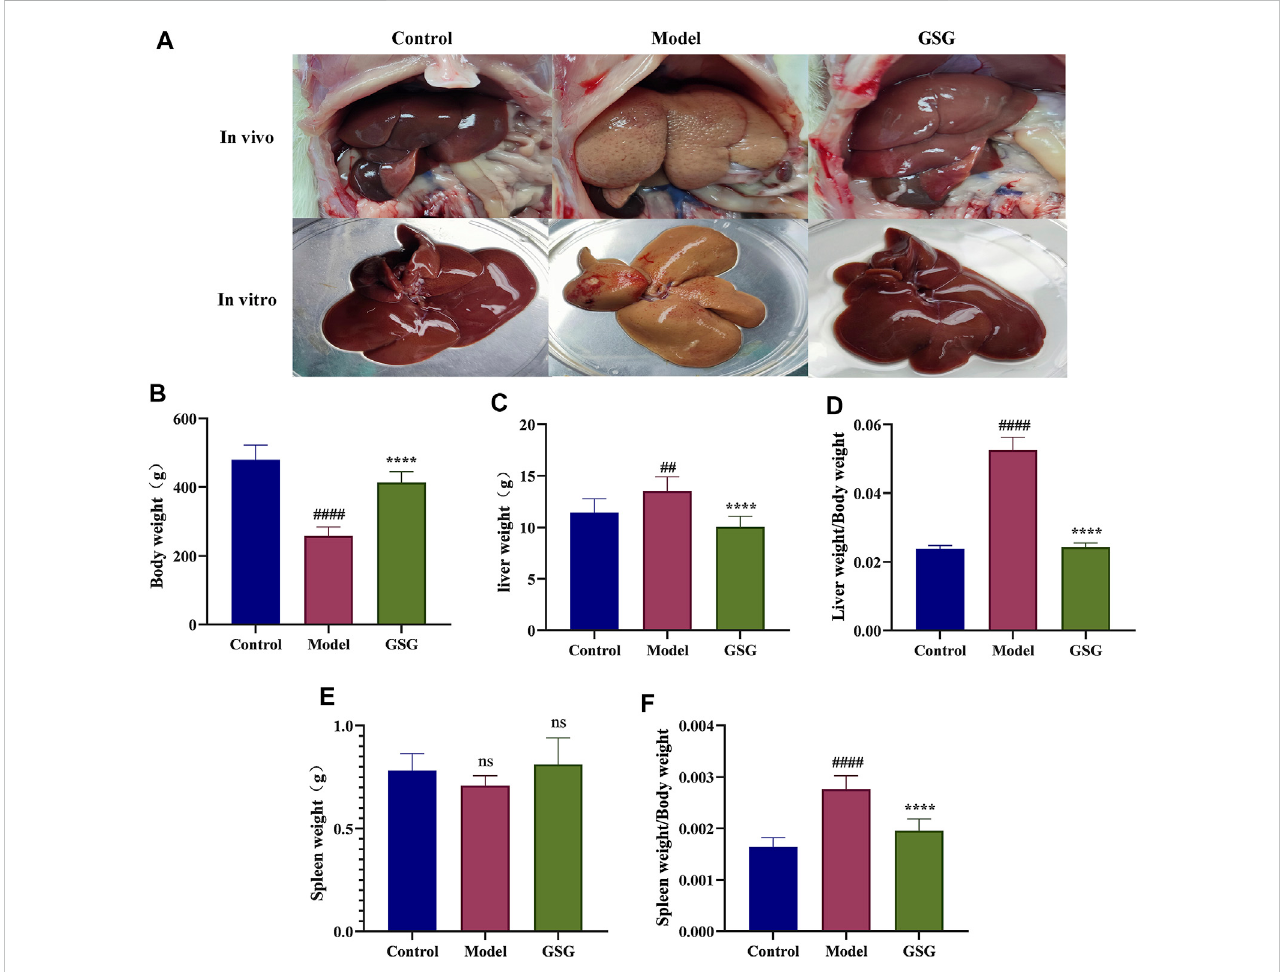
FIGURE 6 General indicators. (A) in vitro and vivo plots of the liver in each group. (B) Body weight. (C) Liver weight. (D) Liver index (liver weight/body weight). (E) Spleen index (spleen weight/body weight). Data are the mean ± S.E.M.; ## p < 0.01, #### p < 0.0001 vs. control; **** p < 0.0001 vs. model; n =